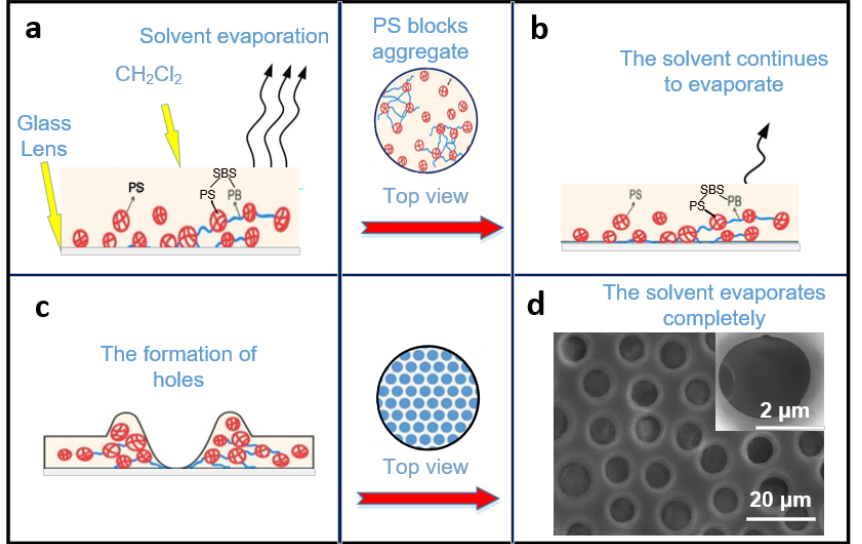
Figure 2. Process of the porous film formation mechanism: ( a ) PS/SBS solution remains stabilized on the glass and solvent evaporate. ( b ) The dichloromethane continues to evaporate. ( c ) The PS interactions lead to the formation of holes. ( d ) The porous structure is formed after solvent evaporate completely.